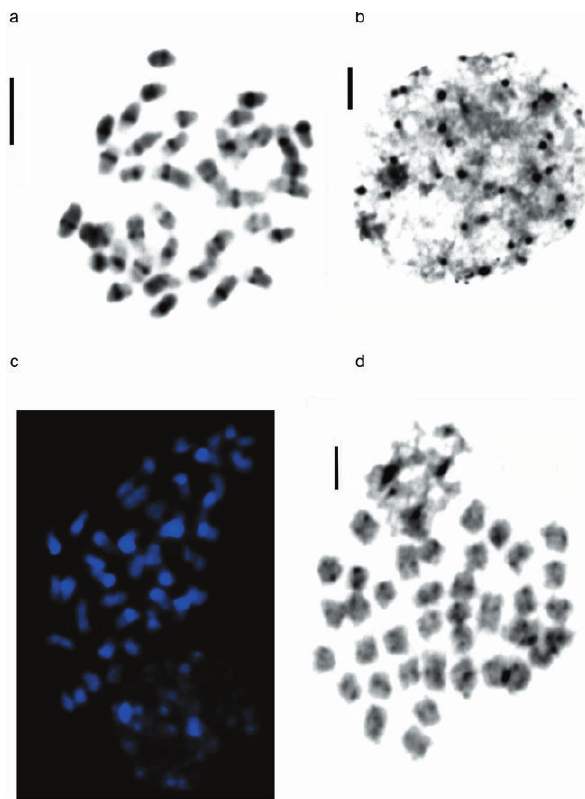
Figure 3. Giemsa C-banded mitotic metaphase of Platanthera chlo- rantha (a) and P. algeriensis (d); in P. chlorantha , interphase nuclei exhibit numerous chromocentres (b); P. chlorantha DAPI stained mitotic metaphase (c). Bar = 5